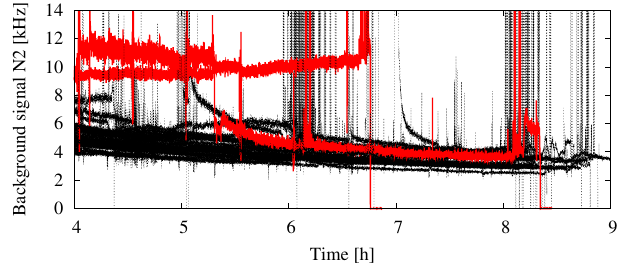
FIG. 23. PHENIX N2 background signal. The two red marked stores had the Yellow electron lens on for 6.75 h and 5.28 h respectively, all other stores had the lenses on between 0.45 to 1.83 h. Zero (the beginning of the store) is suppressed on the horizontal axis to better show the change in the background FIG. 21. Average store luminosity L as a function of the Blue signal when the lenses are turned avg and Yellow average electron lens on-time for the last 40 stores of the 2015 run with a store length of 6 h or longer.